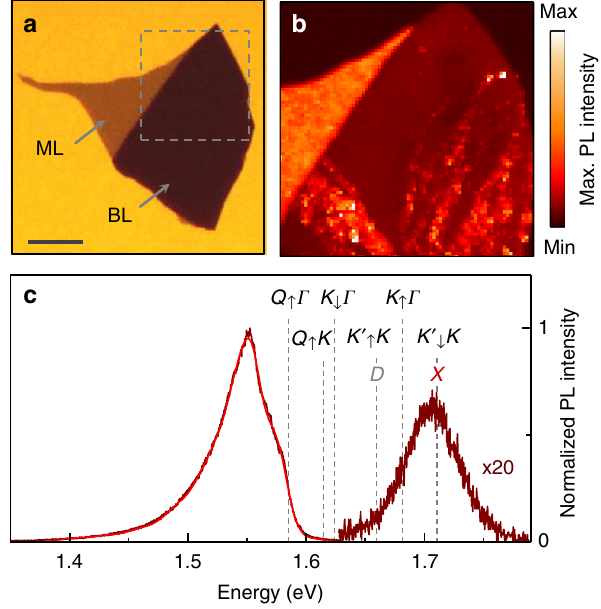
Fig. 1 Photoluminescence spectroscopy of bilayer WSe 2 . a Optical micrograph of a WSe 2 fl ake exfoliated onto Si/SiO 2 with monolayer (ML) and bilayer (BL) regions indicated by the arrows (scale bar, 15 μ m). b Cryogenic raster-scan photoluminescence map of the upper corner indicated by the dashed square in a . False-color plot of the photoluminescence maxima in the spectral range of 1.43 – 1.59 eV. The bilayer exhibits extended and punctual regions of brightening attributed to strain at local folds. c Normalized photoluminescence spectrum (brown, magni fi ed by a factor of 20 in the range of 1.62 – 1.82 eV) at a representative bilayer position away from defects with model fi t shown as red solid line. The energy positions of momentum-bright ( X and D ) and momentum-dark BL excitons ( Q ↑ Γ , Q ↑ K , K ↓ Γ , K 0 " K , K ↑ Γ , and K 0 # K , labeled by the capital letters of electron and empty state valleys and the electron out-of-plane spin as subscript) are indicated by dashed lines. All spectroscopy measurements were performed at 4.2 K with excitation at 1.95